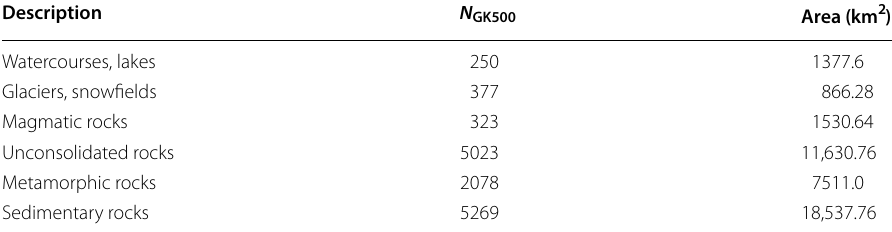
N GK500 is the number of polygons for each category and Area is the total area spanned by all polygons of the